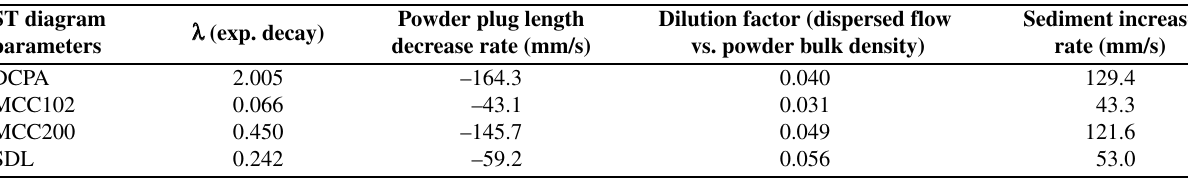
Table 2. Powder plug descent dynamics (upper part) , powder plug length decrease rate, dilution factor and sediment increase rate for the closed pi- pe condition and all tested materials: dicalcium phosphate anhydrous (DCPA), microcrystalline cellulose MCC102 and MCC200, and spray-dried lactose